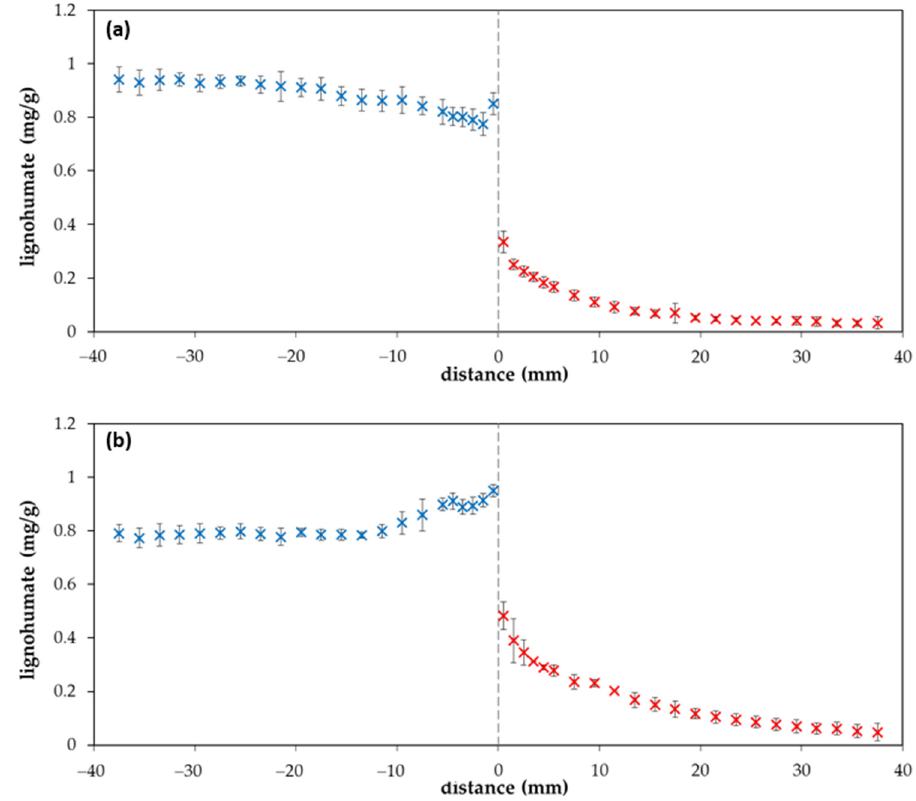
Figure 3. Concentration profiles of lignohumate in agarose hydrogel after two ( a ) and ten ( b ) days. The blue points belong to the donor hydrogel (distance x < 0), the red points belong to the acceptor hydrogel (distance x > 0).